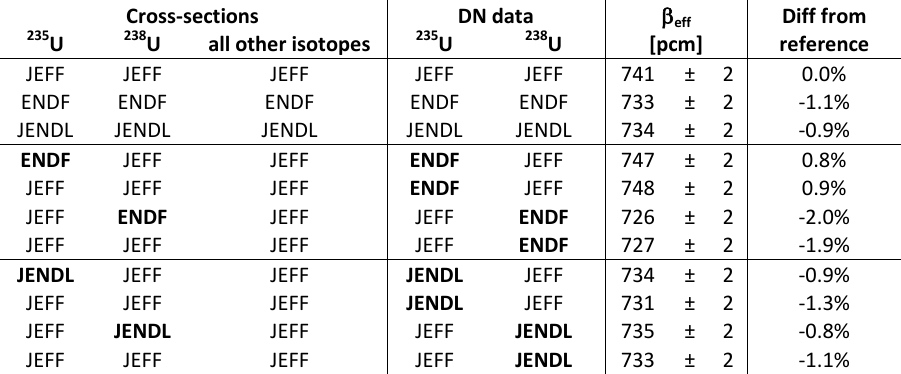
Table 2. Effective delayed neutron fraction calculated with MCNP using JEFF-3.1.2, JENDL-4.0, ENDF/B-VII.1 libraries for cross sections and delayed neutron